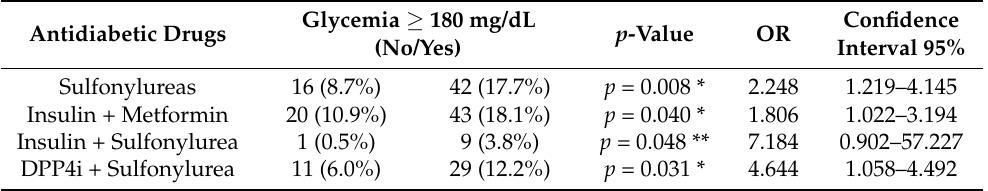
Table 5. Relationship between Antidiabetic drugs and serum glycemia level at admission. Antidiabetic